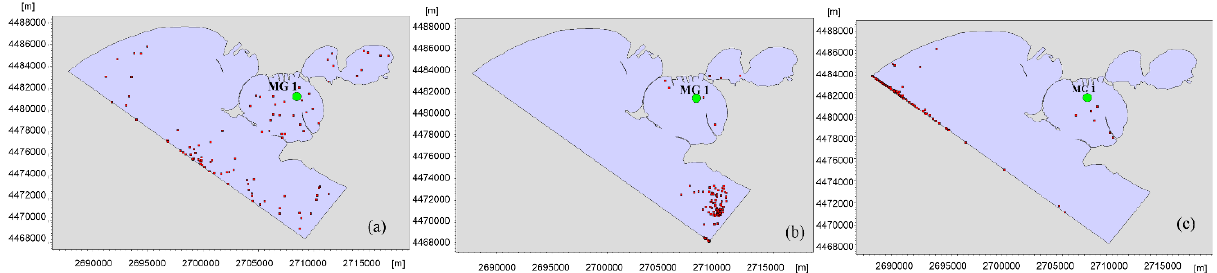
Figure 10. Percentage PT1 (MG1) — the cloud of particles: ( a ) 30 days after release; ( b ) 60 days after release; ( c ) 30 days after release at surface layer.